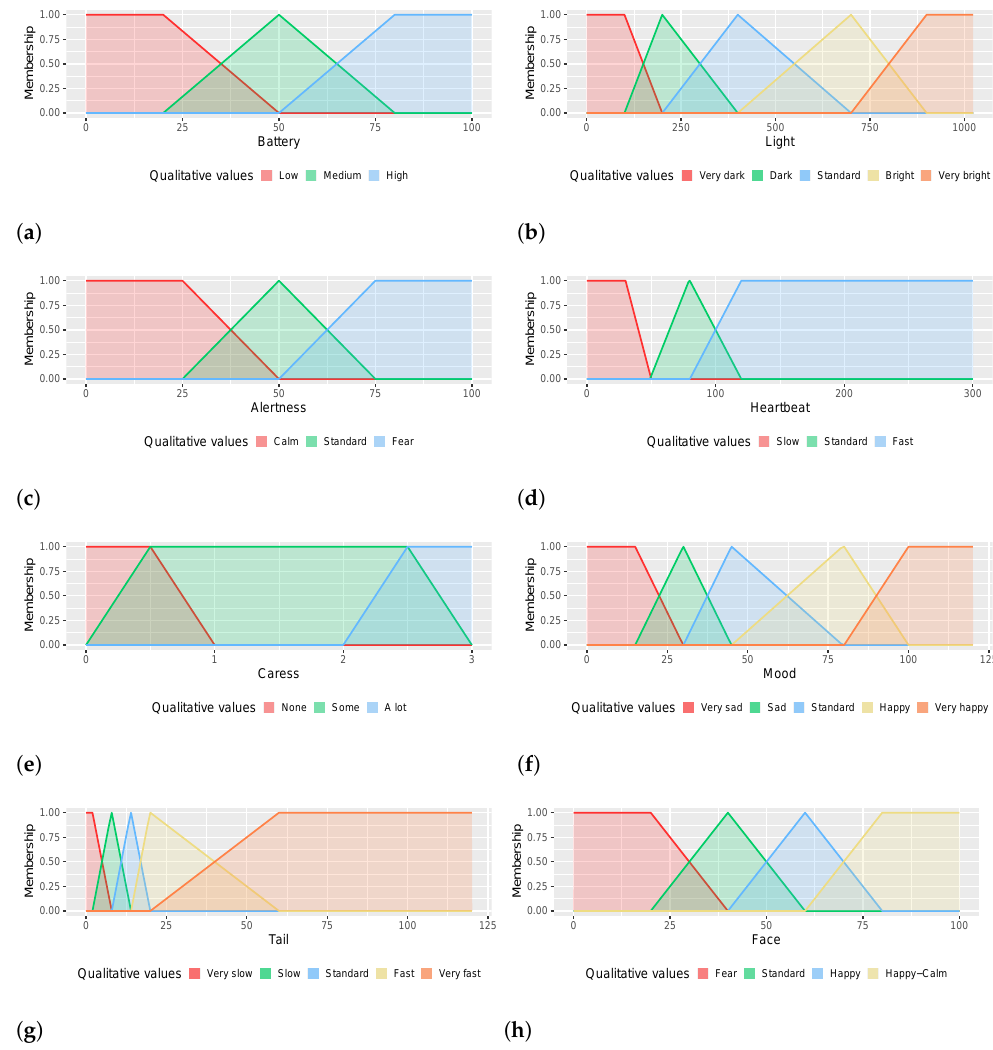
Figure 8. Membership functions. ( a ) battery charging, ( b ) light level, ( c ) ALERTNESS emotion, ( d ) heartbeat state, ( e ) caress level, ( f ) MOOD emotion, ( g ) tail movement, ( h ) facial